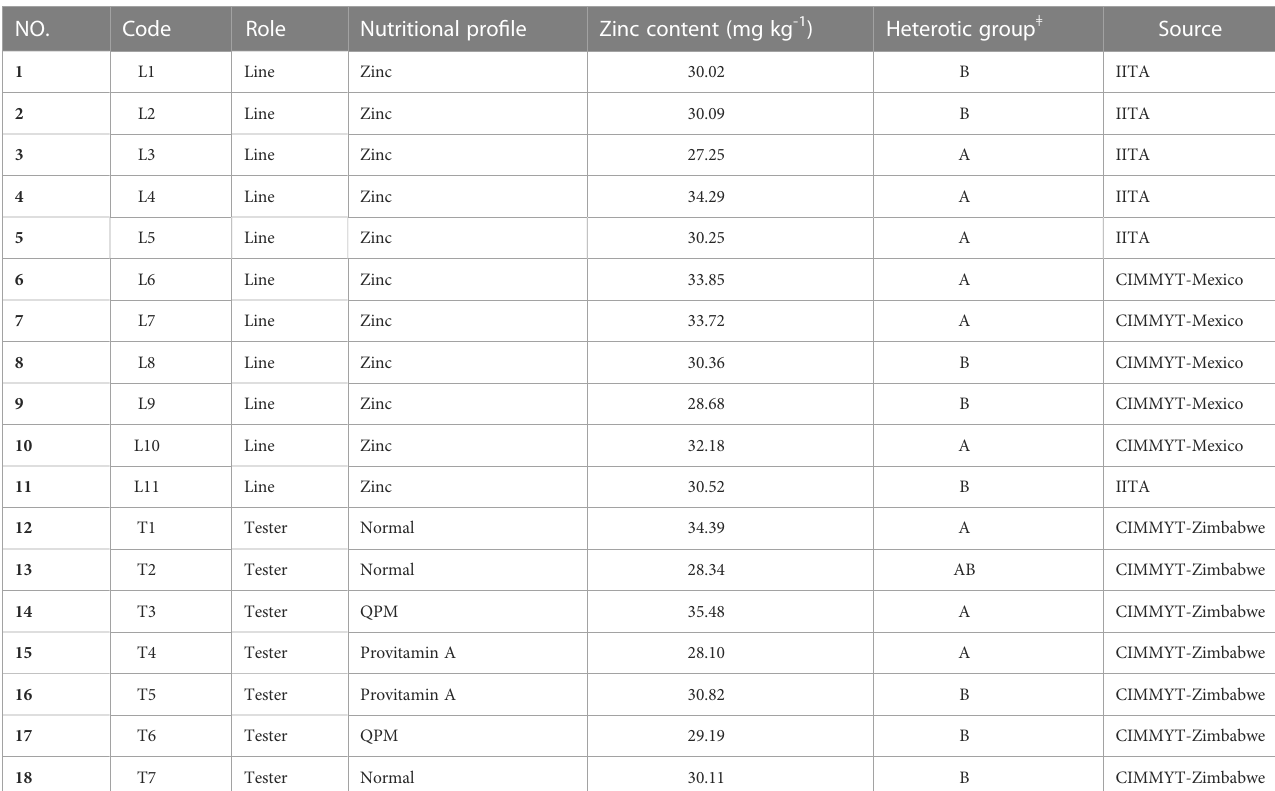
TABLE 1 Description of the plant materials used for making crosses.